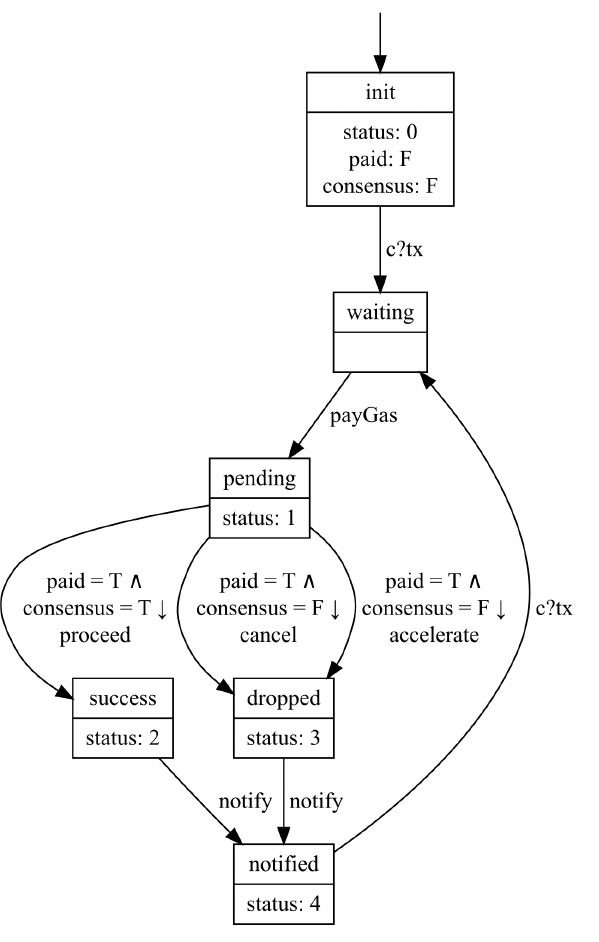
Figure 3. Visualized system graph of a refined transaction client in Example